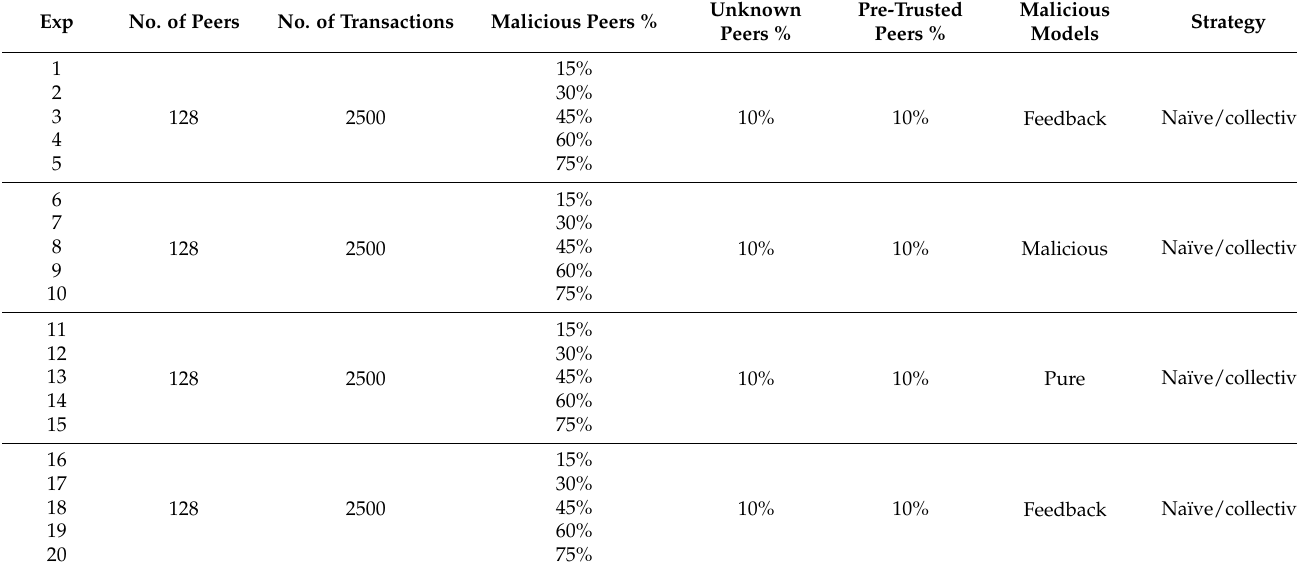
Table 1. Summary of simulation